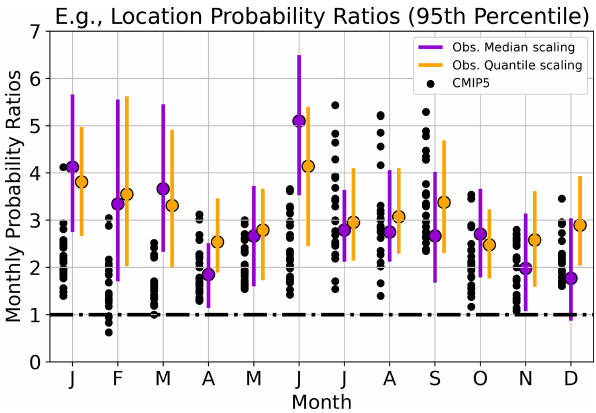
Figure 2. Seasonal cycles of probability ratios at the 95th percentile in Phoenix, calculated with the observation-based median-scaling (purple) and quantile-scaling (orange) methods and the model- based method (black). Purple and orange dots and bars show the median and 95% confidence intervals for the observation methods, respectively; each black dot shows the PR of an individual model from the CMIP5 ensemble. The black dashed line at PR = 1 is the boundary above which the probability of occurrence is greater in the human-forced climate than the counterfactual climate. Distributions with confidence intervals (or model ensemble estimates with all but one member) greater than PR = 1 are statistically